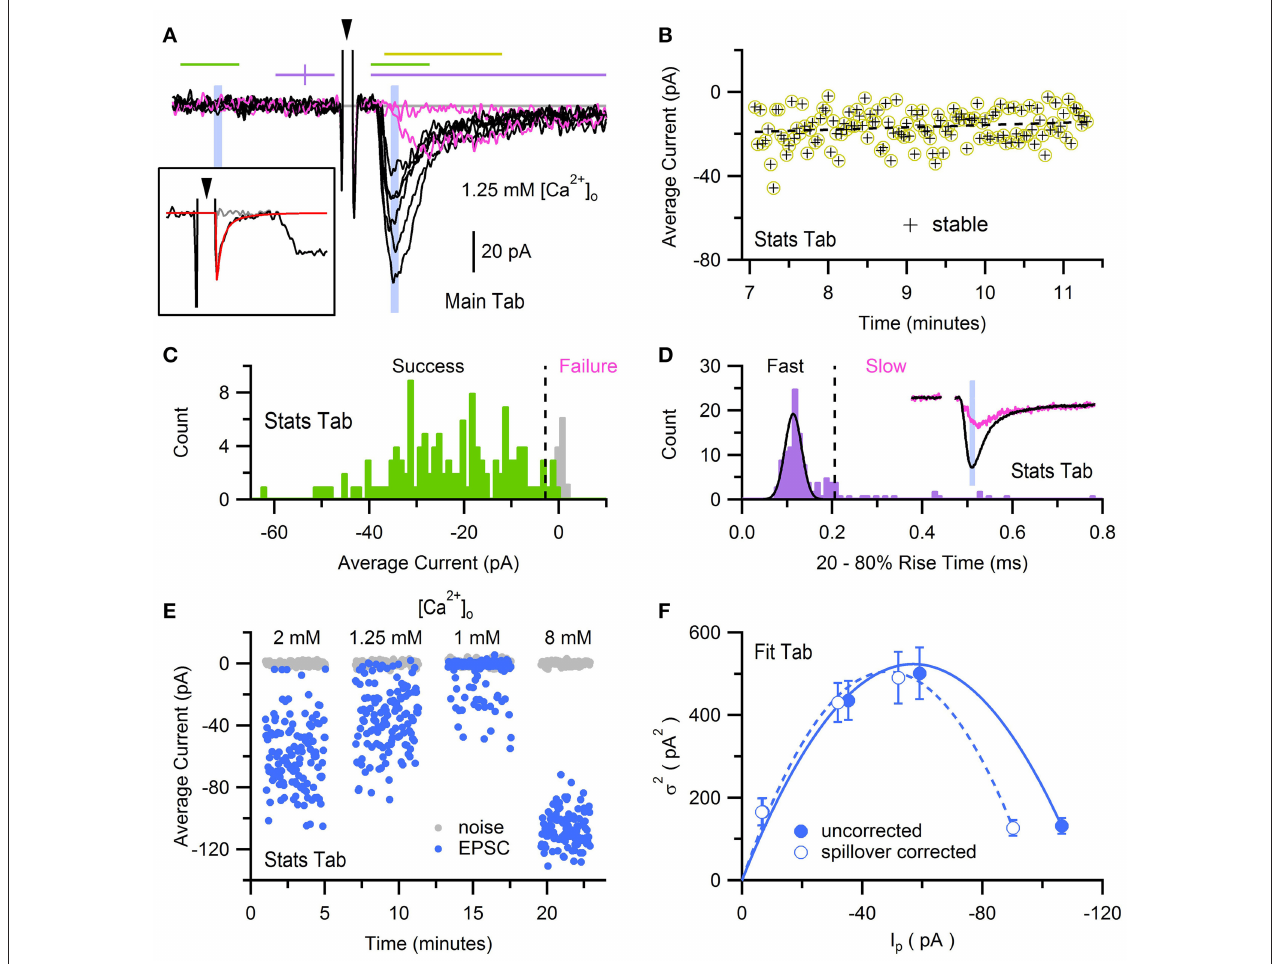
FIGURE 10 | Multiple-probability fluctuation analysis with glutamate-spillover-current correction. Fluctuation analysis of AMPAR EPSCs recorded from a GC in whole-cell voltage-clamp mode in the presence of 1–8mM [Ca 2 + ] o , evoked by stimulation of a single MF input at 0.5Hz. Data was acquired via an Axopatch 200B amplifier and pCLAMP software (100kHz sample rate), saved in Axon binary format (ABF). (A) Eight superimposed EPSCs from a total of 128 evoked in ACSF containing 1.25mM Ca 2 + . Black traces are fast-rising direct EPSCs and pink traces are non-direct EPSCs (one failure and one slow rising). Recordings were baseline subtracted (GUI/Main/Baseline) which computed the average current within a 1ms window just before the stimulus (first purple line) and subtracted the average from the recording. The large biphasic current preceding the EPSC is the stimulus artifact (arrowhead, clipped at + 27pA) of which the final decay component was subtracted (see inset). Lines and shaded regions define Stats analysis windows as used in Sargent et al. (2005): stability (yellow, 2ms), success/failure (green, 1ms), rise time (purple, 5ms, clipped to 4ms), peak amplitude (blue, 0.1ms). Background noise windows (green and shaded blue) are reflected at the baseline midline (purple vertical tick). Gray line denotes 0 current. Inset , a single stimulus artifact before (black) and after (gray) subtracting a double-exponential fit (red) to the final decay component of an average artifact computed from 16 recordings with no or little EPSC. (B) Stability analysis for the 128 EPSCs recorded in 1.25mM Ca 2 + . Each data point denotes the average current in a 2ms window that includes the EPSC peak, denoted by the yellow line in (A) . Dashed black line denotes regression analysis. For this data set the stable region included all 128 recordings. (C) Histograms (GUI/Stats/Stats2/Functions/Histogram; 1pA bins) of average peak current (green) and background current (gray) of stable responses in (B) computed in the 1ms windows denoted by green lines in (A) . Dashed line denotes 3 STDVs of the background current ( − 2.8pA), the dividing line between failures and successes ( n = 4 and 124, respectively). (D) Histogram (0.01ms bins) of 20–80% rise times (see Figures 2 , 3 ) of successful EPSCs defined in (C) , where baseline and peak detection windows are denoted by purple lines in (A) , and traces were low-pass filtered at 4kHz. Black line is a Gaussian fit to the distribution (Menu/Analysis/Curve Fitting.../gauss). Dashed line at 0.22ms denotes 5 STDVs above the Gaussian peak center, the dividing line between slow and fast EPSCs ( n = 19 and 105, respectively). A second criteria based on the rise-time slope (GUI/Stats/Stats1/RTslope; not shown) re-categorized 7 slow EPSCs as fast. Inset , averages of EPSCs in the Fast set (black; n = 112) and Slow set (pink; n = 12). Blue shaded region is a 0.1ms window centered on the peak of the average fast EPSC, the same window in (A) . (E) Average current of background noise (gray circles) and EPSC peak (blue circles) of stable responses in (B) , computed in blue shaded 0.1ms windows in (A) . Analysis was repeated for recordings in 1, 2 and 8mM [Ca 2 + ] o . (F) σ 2 I − I p relation computed from data in panel (E) before and after spillover correction (closed and open circles, respectively). Lines are multinomial fits (Equation 2) with values given in the main text. GC experimental details: cerebellar slice from a P25 rat, R a = 28 M (cid:127) , C mem = 3.4 pF, V hold = − 76mV. Data is from Sargent et al. (2005), their Figure